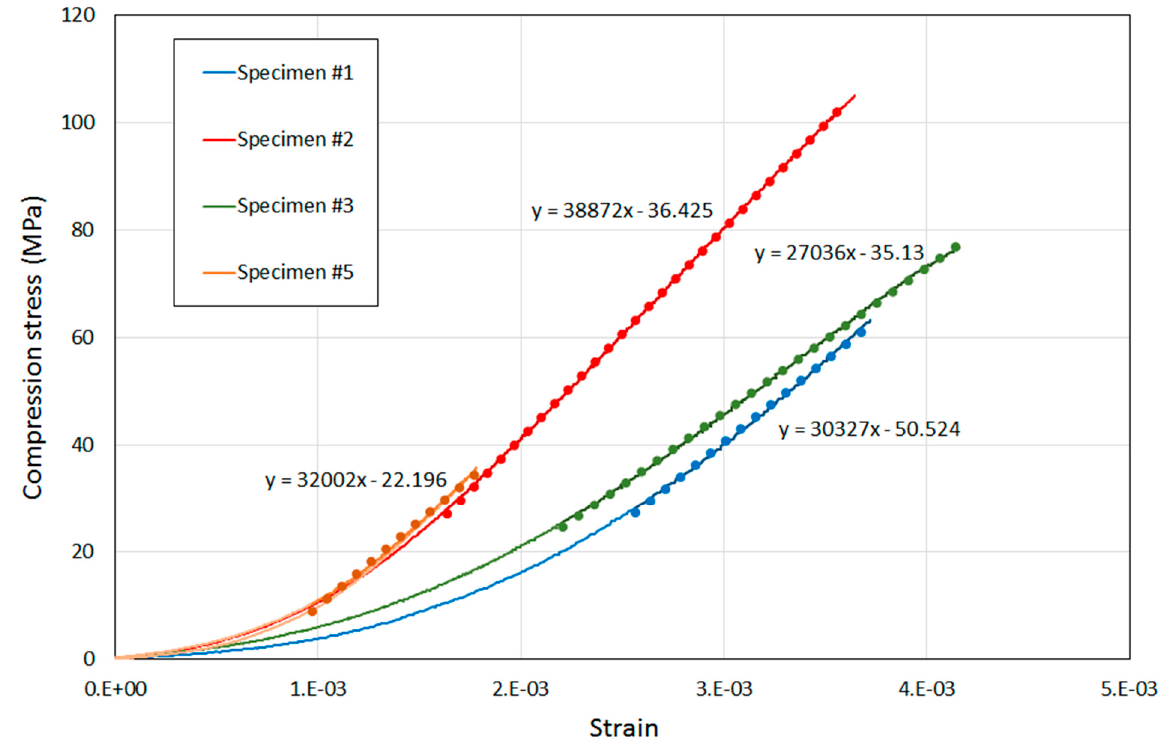
Figure 7. Uniaxial compression tests performed with 4 sandstone specimens (Table 2). Table 2. Results of simple compression